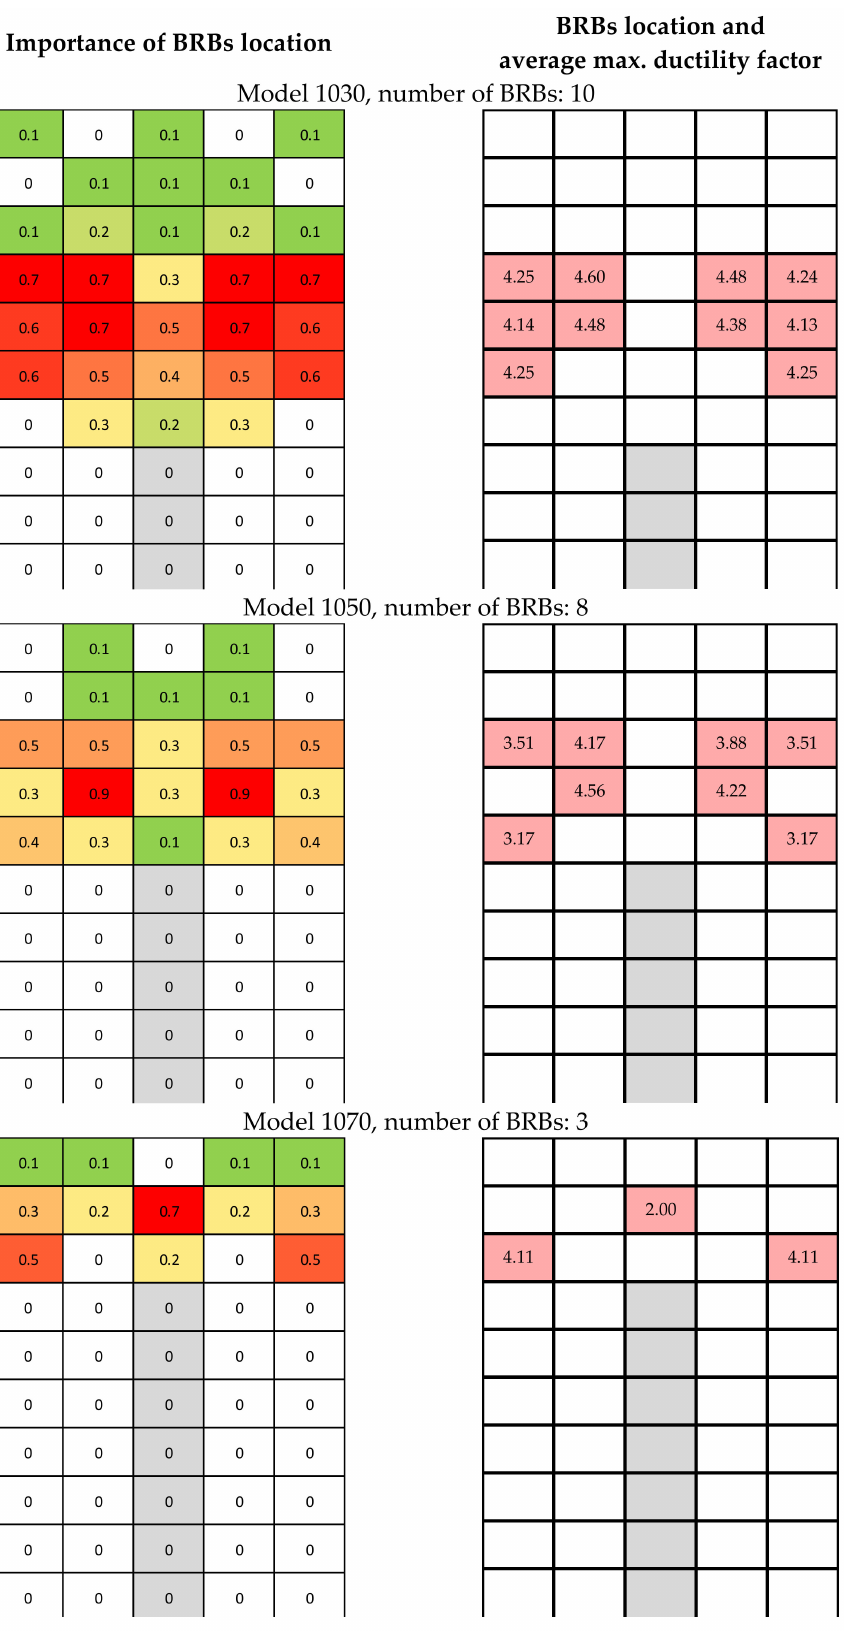
Figure 20. Implementation of BRBs placement for 10 stories based on optimization under 10 input